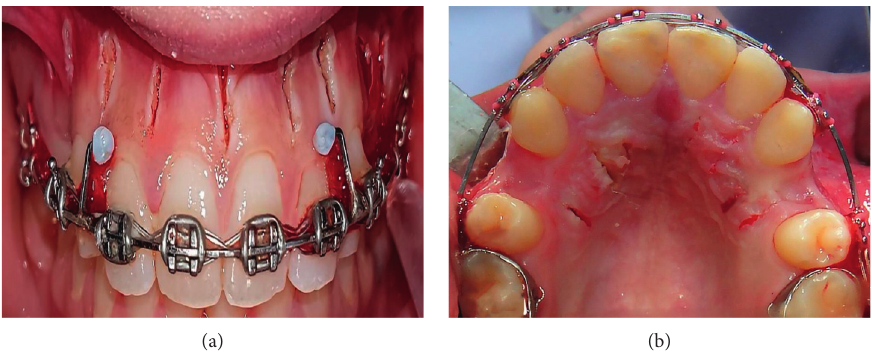
Figure 2: The flapless corticotomy from the buccal view (a) and the palatal view